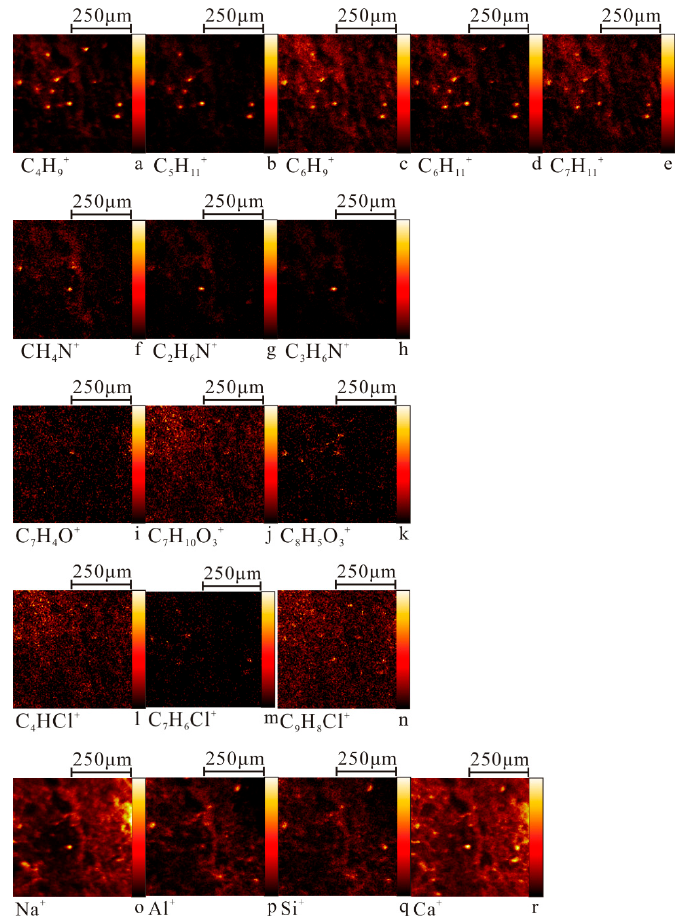
Figure 2. Time-of-flight secondary ion mass spectrometry (ToF-SIMS) maps of some characteristic ions of MPs in XA1 (a-e) PP; (f-h) PA6; (i-k) PET; (l-n) PVC.